Question: Write a descriptive caption for this figure.
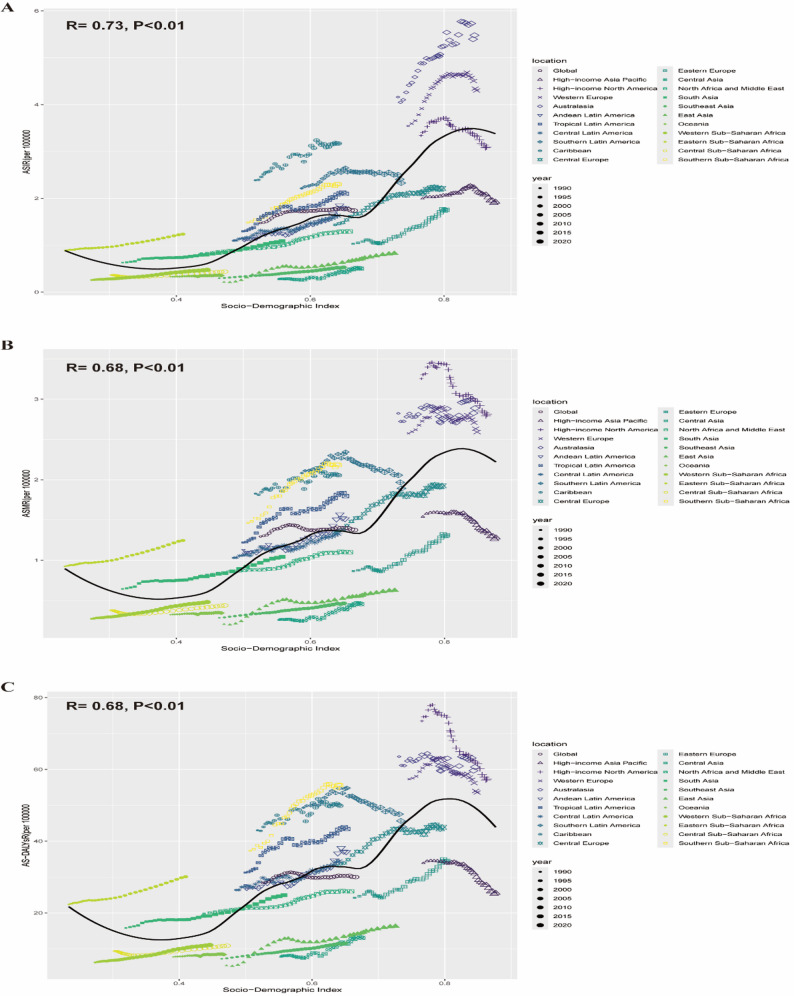
Answer: Trends and correlation of ASRs with SDI from 1990–2021. A ASIR and SDI trends and their relationship in 22 regions. B ASMR and SDI trends and their relationship in 22 regions. C AS-DALYsR and SDI trends and their relationship in 22 regions